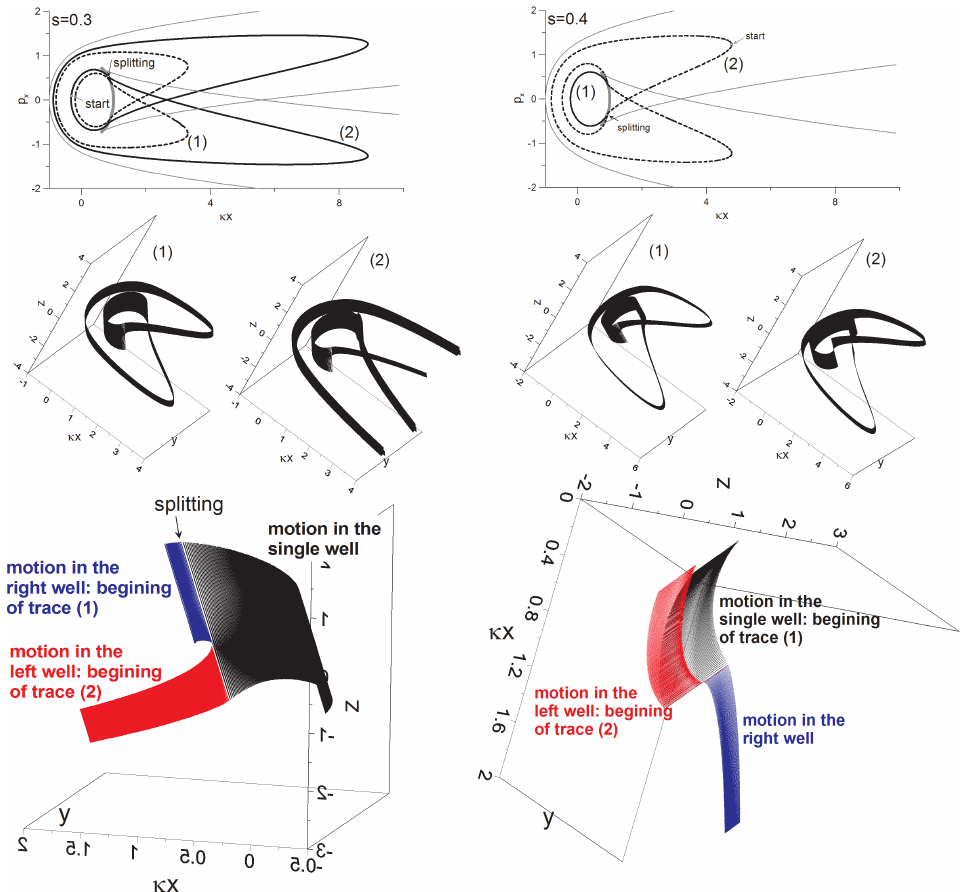
Fig. 7. Trajectories in 3D obtained by numerical integration of the Hamiltonian equations are shown for 𝑠 =0 . 3 and 𝑠 = 0 . 4 . Projections of these trajectories onto ( 𝜅𝑥,𝑝 𝑥 ) plane are also shown. In 3D we demonstrate only segments of each trajectory corresponding to the top panels with projections. Bottom color panels show moments of trajectory splitting for both values of 𝑠 .